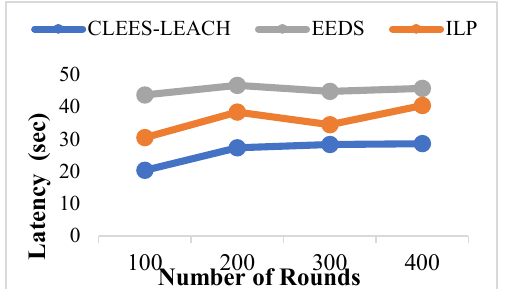
Figure 15 indicates the comparison values of Latency with the existing and the proposed routing mechanism.